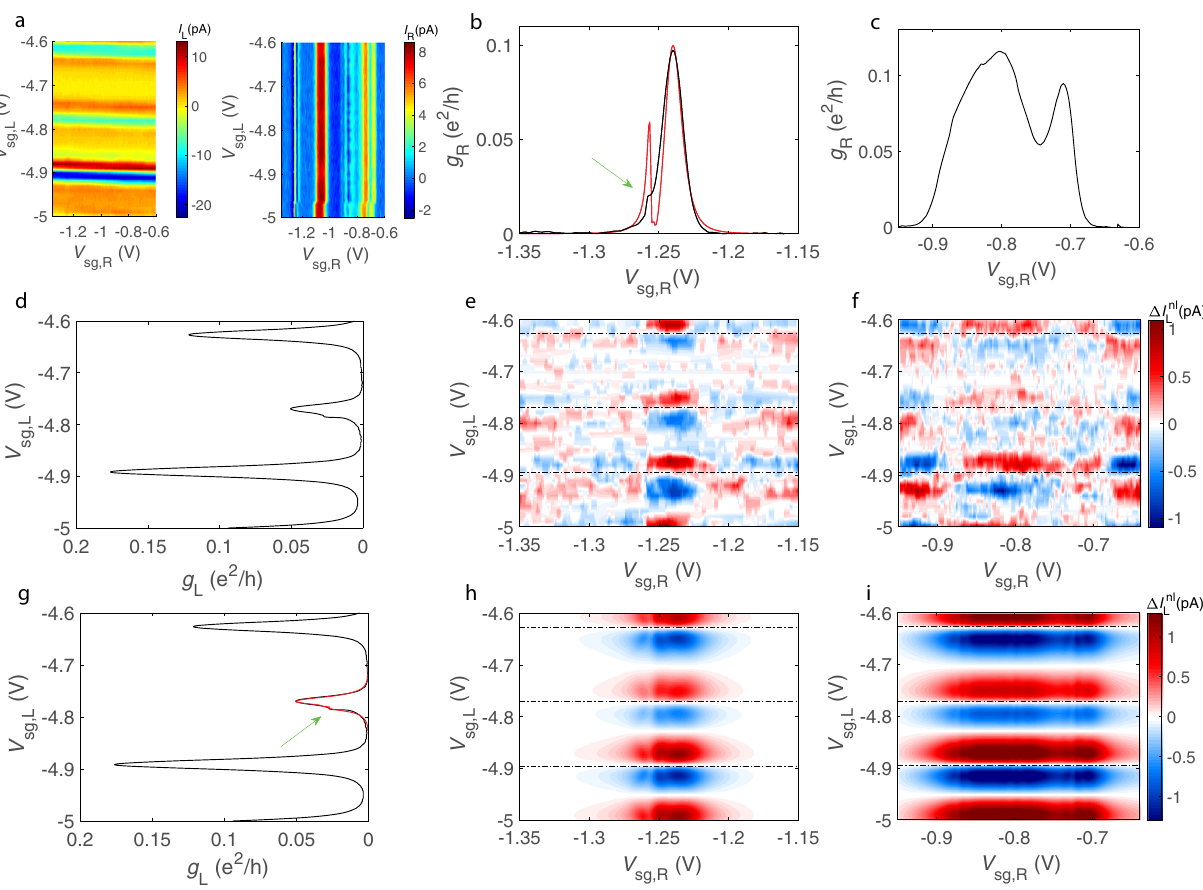
Fig. 2 Local and non-local contributions to the thermoelectric current. a Thermally generated current at 2 f in the left and right dot measured as a function of V sg,L and V sg,R ; the data include both local and non-local thermoelectric contributions. b , c Zero bias conductance of the right quantum dot vs. V sg,R in two intervals: − 1.35 V < V sg,R < − 1.15 V, and − 0.95V < V sg,R < − 0.6 V; green arrow in the b points to the minor peak in the vicinity of the main conductance ¼ 120 μ eV, t = 55 μ eV; the peak, and the red curve is the fi t by the Fano resonance model with the parameters Γ R = 20 μ eV, γ R = 252 μ eV, ε R (cid:1) ε 0 R R additional Fano peak in the fi t is intentionally made stronger than the experimentally observed one in order to better reproduce the behavior of the non- local thermoelectric current in Fig. 3d. d Zero bias conductance of the left quantum dot in the interval − 5 V < V sg,L < − 4.6 V. e , f Experimental non-local contribution to the thermal current in the left quantum dot, Δ I nl , in two selected regions of ( V sg,R , V sg,L ) plane. g Zero bias conductance of the left quantum L dot; data as in d , but the red curve displays the fi t of one of the peaks with the Fano resonance model with the parameters Γ L = 6 μ eV, γ L = 98 μ eV, ε (cid:1) ε 0 ¼ 24 μ eV, and t = 10 μ eV. h , i Theoretically predicted non-local contribution Δ I nl in the same regions as in e , f L L L L